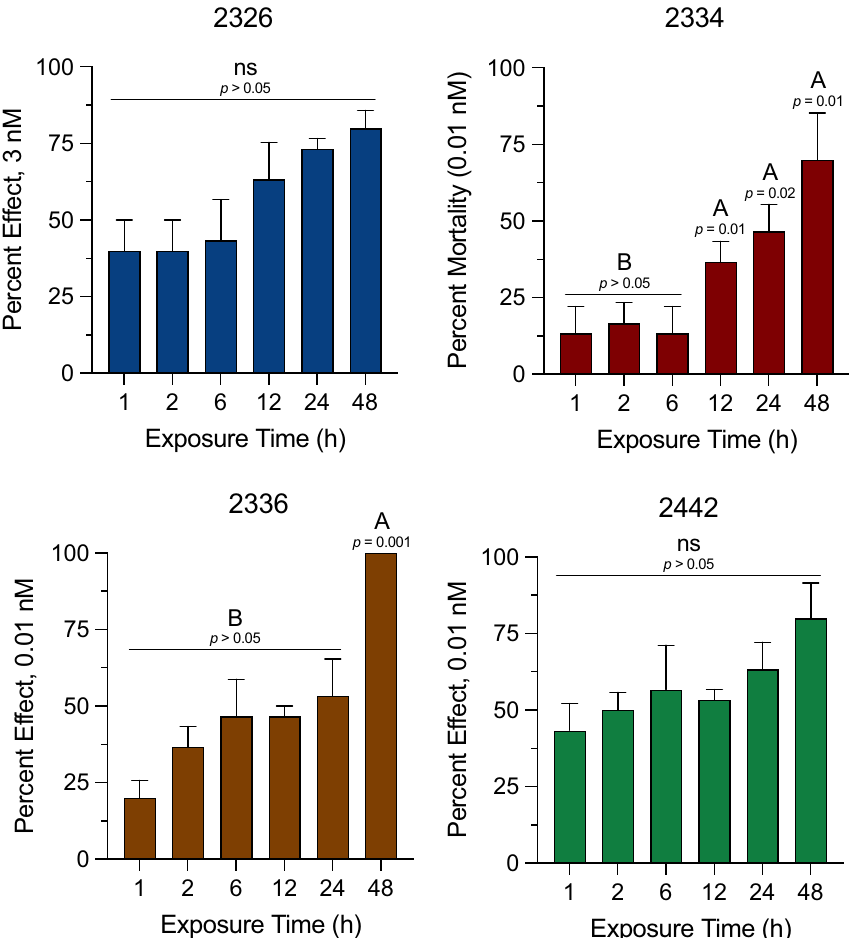
Figure 4. Proctolin peptidomimetics activities. Time-dependent efficacy of peptide mimics to Varroa mites. Immobilized Female Varroa mites were topically treated on the gnathosoma; 2326 at 3 nM and 2334, 2336, and 2442 at 0.01 nM and the number of mites affected (i.e., paralyzed or dead) was recorded for 1 to 48 h post- treatment. Vertical bars represent the mean ± standard error. Different letters above the bars indicate a significant difference between the mean percent effect at each time point using a one-way ANOVA with a Tukey’s post-hoc test ( p < 0.05). The mortalities in water controls were ~ < 10% at 48 h exposure.